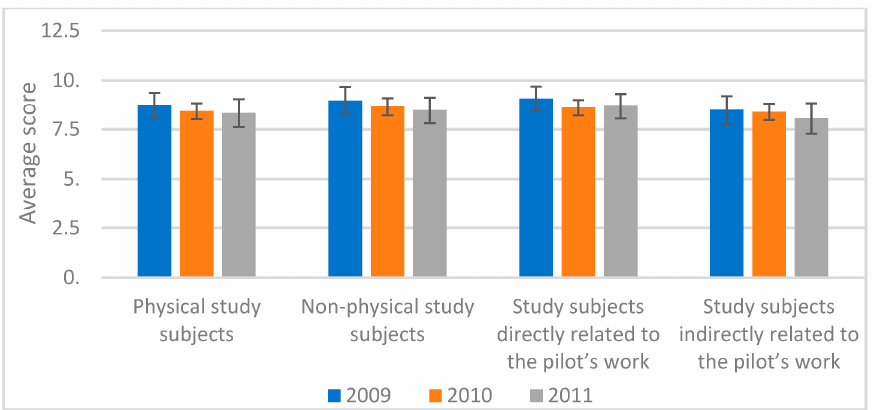
Figure 4. Assessment results for the study subject groups in different admission years (source: created by the authors).